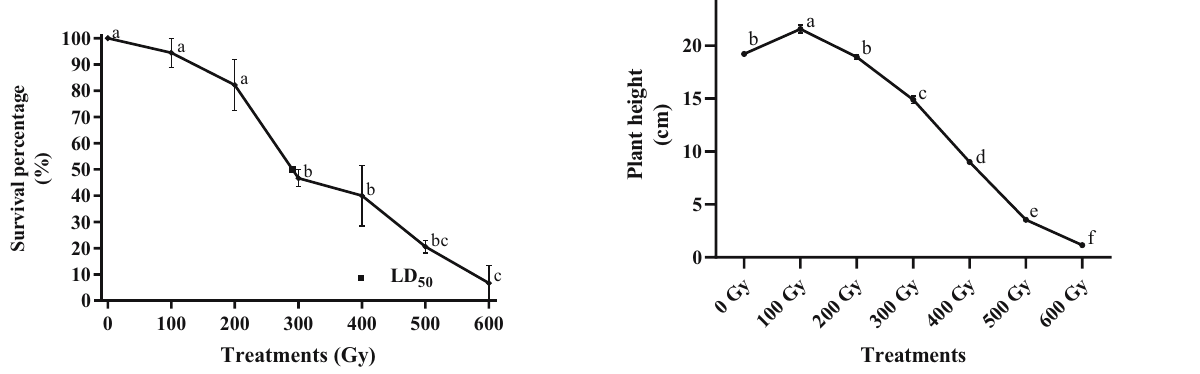
Figure 4: Plant height of irradiated wheat var. CIRNO C2008 seeds. Di ff erent letters indicate a signi fi cant di ff erence ( Tukey HSD p < 0.05 )